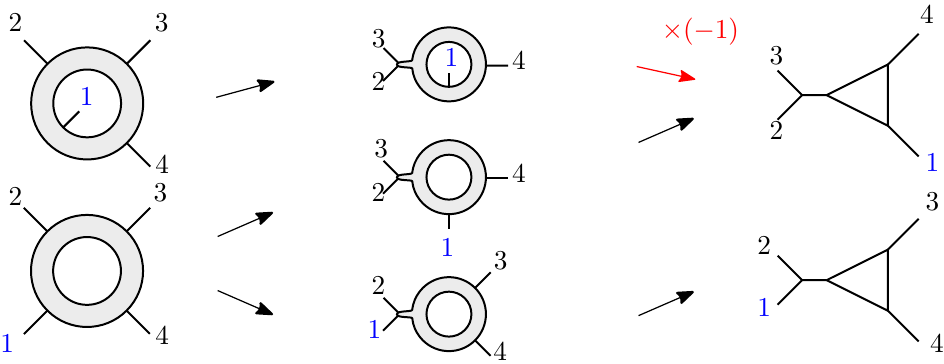
Figure 5 . Triangles obtained by bringing (cid:23) 2 close to (cid:23) 3 , or to (cid:23) 1 . The latter is not possible for the upper vertex con(cid:12)guration, in which (cid:23) 1 is on the other boundary of the annulus.